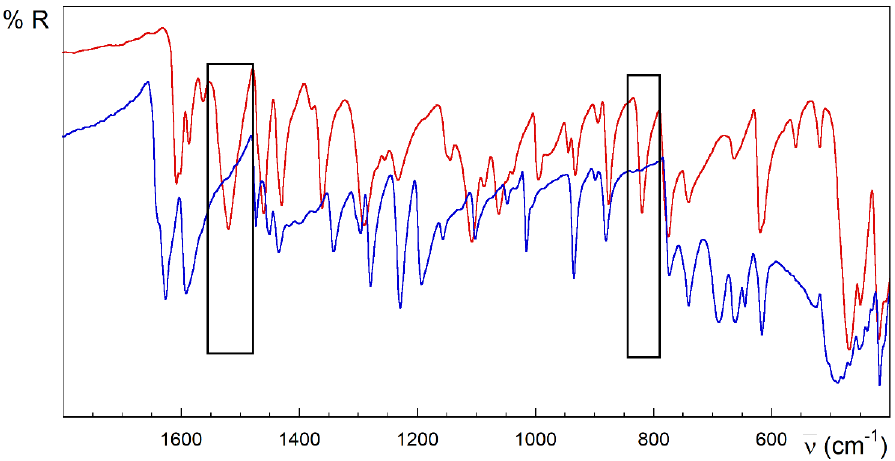
Figure 4. FTIR-ATR spectra of HL (red) and 3 (blue). Rectangles in black highlight the main differences between the spectra of the free ligand and the complex.